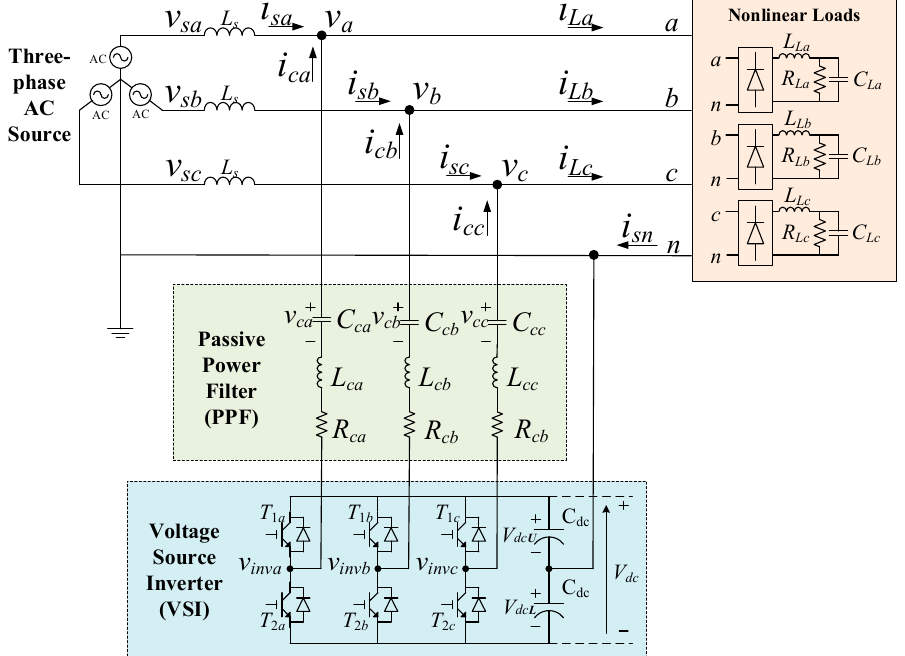
Figure 2. The circuit configuration of a three-phase four-wire LC -HAPF with balanced nonlinear load.